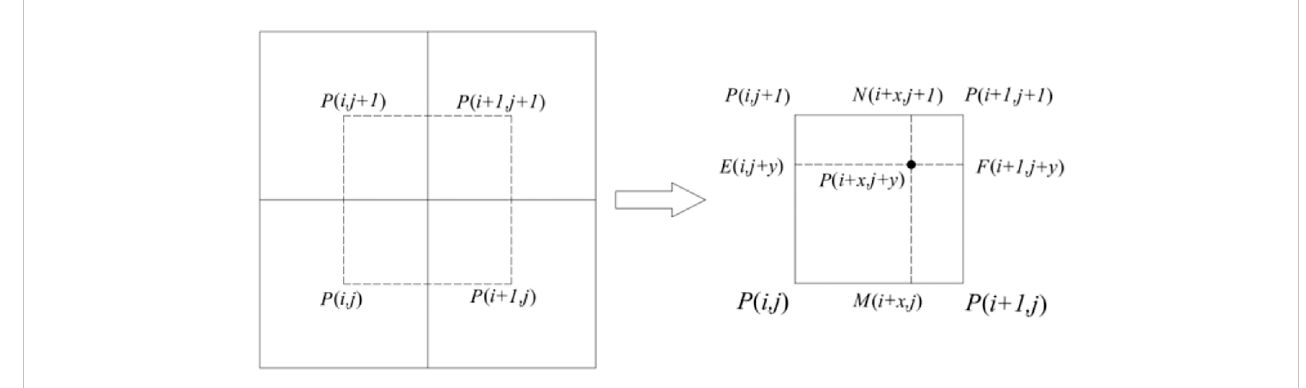
FIGURE 7 Subdivision process of pixel-level units by bilinear interpolation.